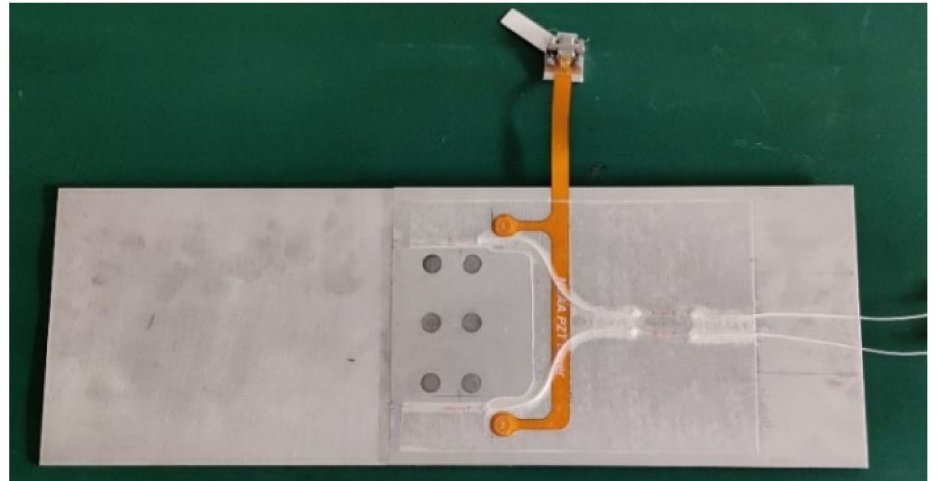
Figure 5. Specimen with the PZT smart